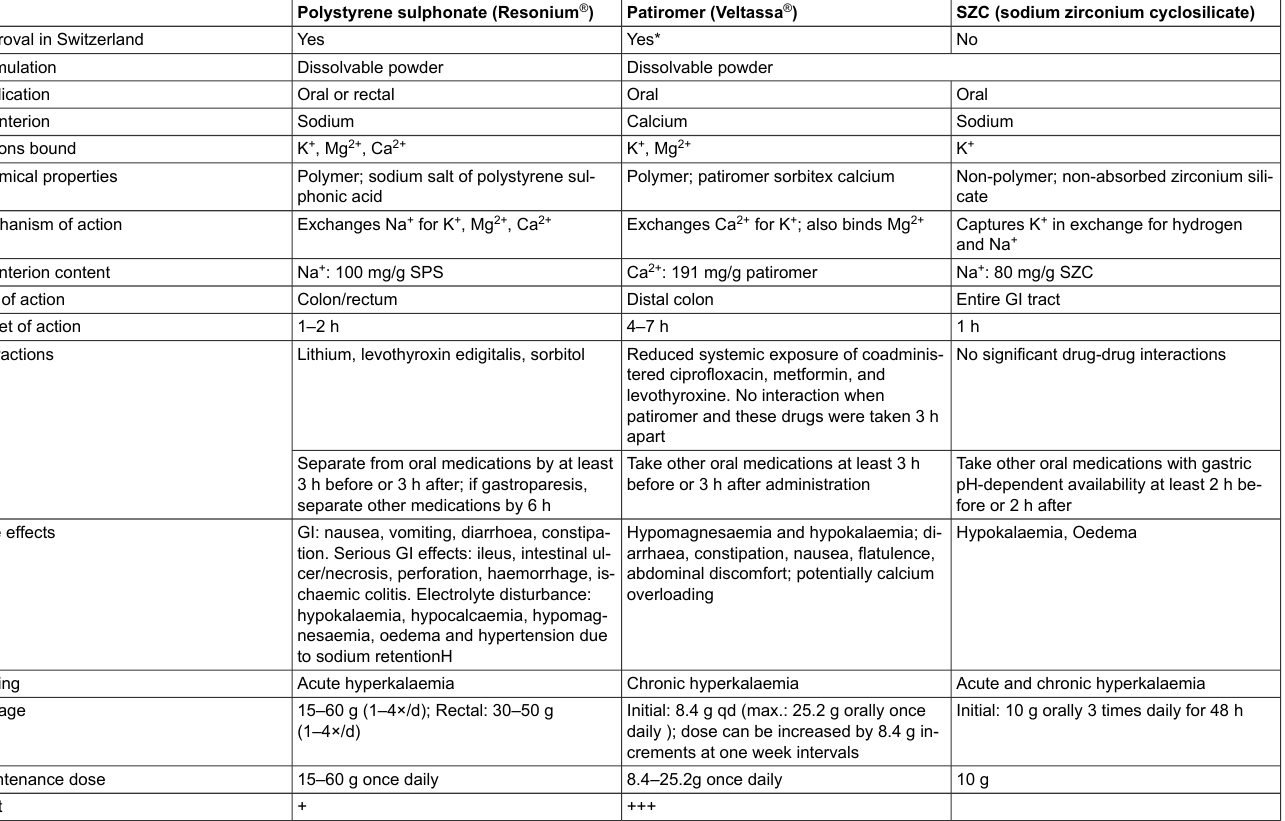
Table 7: Potassium binders (modified from